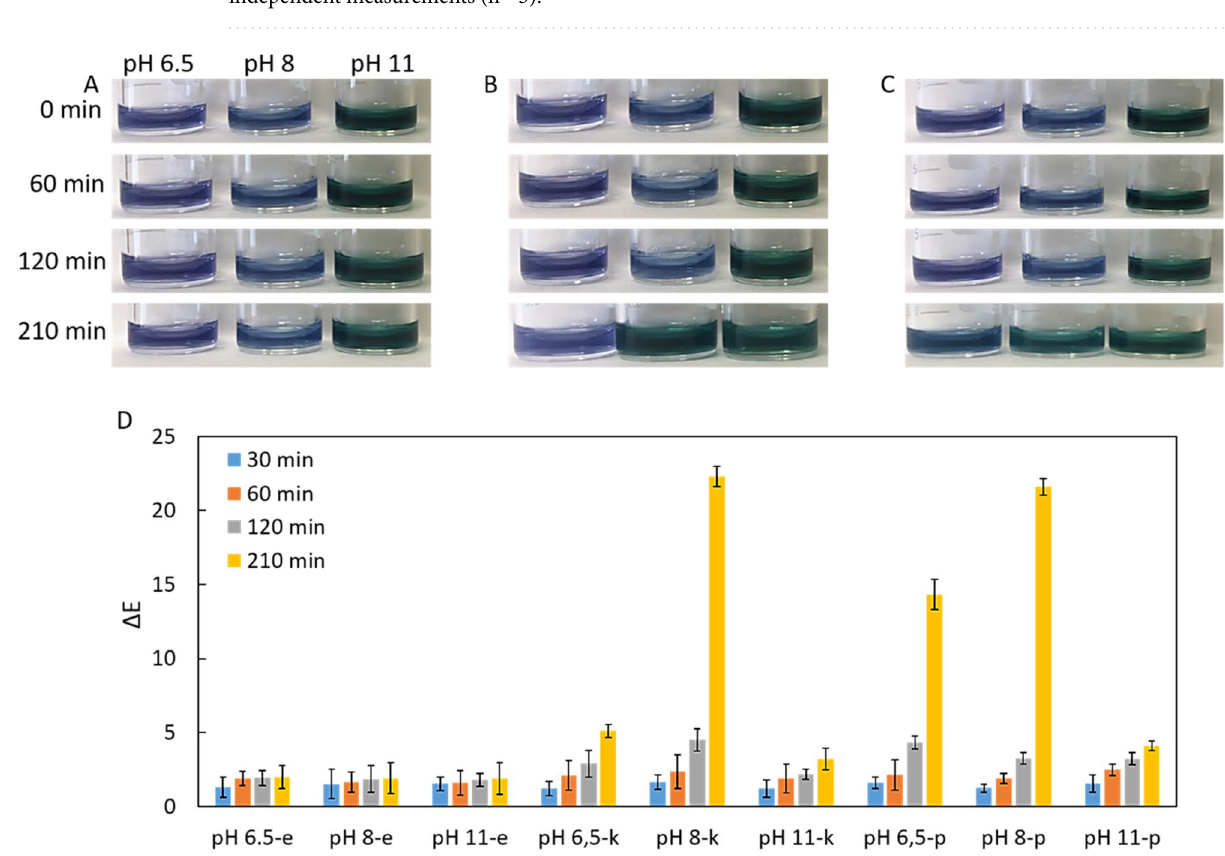
Figure 6. Colorimetric readouts of the urease test with a naked eye for ( A ) E. coli, ( B ) K. pneumoniae and ( C ) P. mirabilis . ( D ) With ΔE analysis. The error bars demonstrate one standard deviation (SD) obtained from three independent measurements (n =